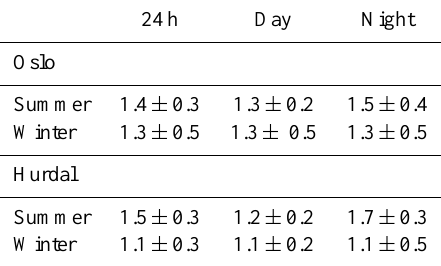
Table 5. Mannitol-to-arabitol ratios for PM 10